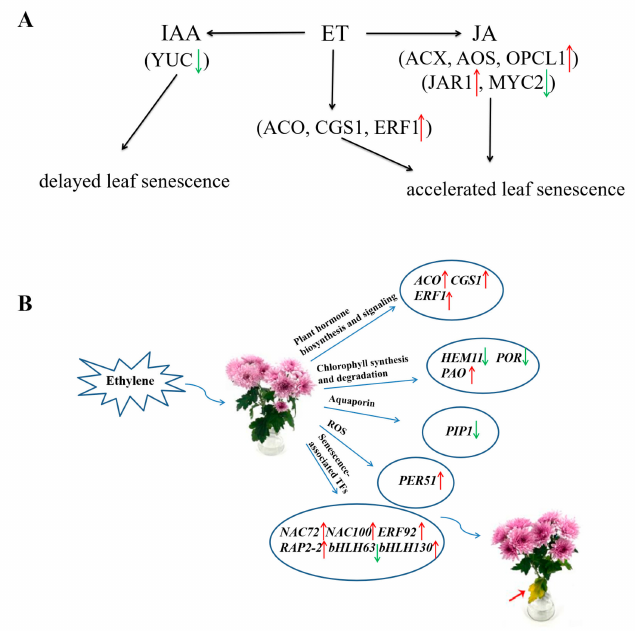
Figure 8. Working model of ethylene (ET)-mediated chrysanthemum leaf senescence. ( A ) Ethylene- induced leaf senescence module by regulating other plant hormones. ( B ) ET may promote senescence of chrysanthemum leaves by regulating genes that are mainly related to plant hormone biosynthesis and signaling (e.g., ACO , CGS1 , and ERF1 ), chlorophyll synthesis and degradation (e.g., HEMM11 , POP , and PAO ), aquaporin (e.g., PIP1 ), ROS (e.g., PER51 ), and senescence-associated transcription factors (TFs) (e.g., NAC72 , NAC100 , ERF92 , RAP2 -2, bHLH63 , and bHLH130 ). Red arrows represent upregulation, and green arrows represent downregulation. ROS, reactive oxygen